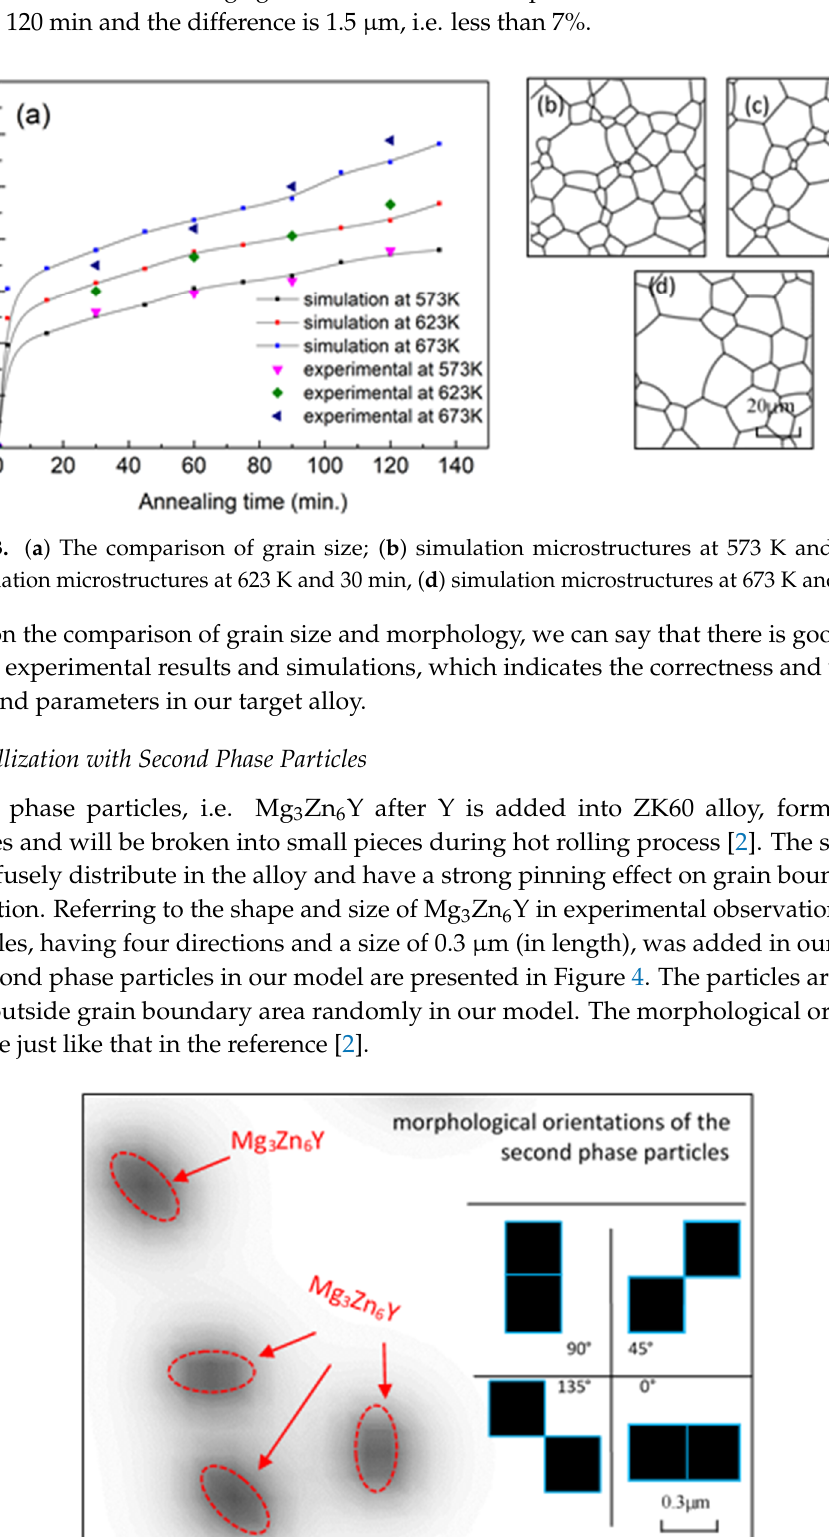
Figure 4. Second phase particles setting in phase field model.